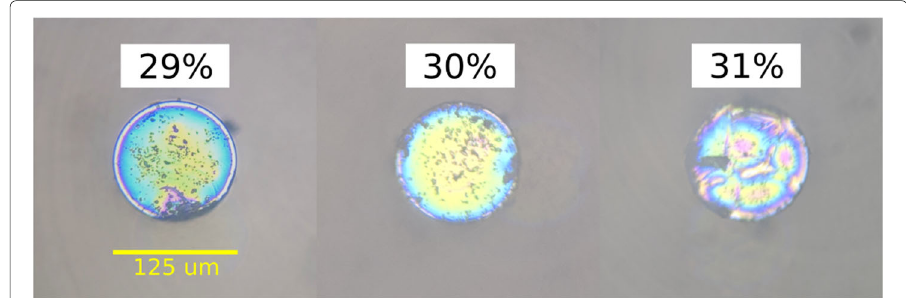
small optical power (up to 100 μ W) which has negligible effect on the frequency shift noise. The simiplicity of using only a single fiber outweighs the reduced bolotmetric actuation efficiency, particularly, in vacuum/cryogenic temperature